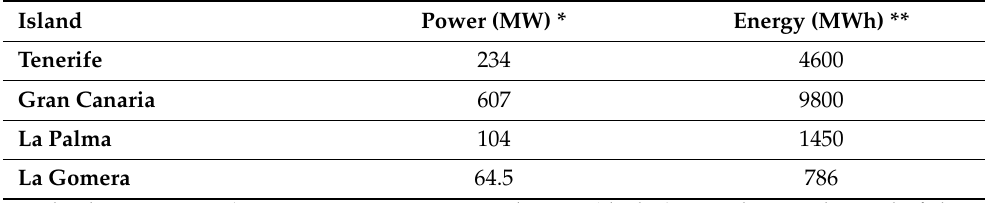
Table 5. Summary of the estimated reverse pumping storage capacity in the Canary Islands [43]. Island Power (MW) * Energy (MWh) ** Tenerife 234 4600 Gran Canaria 607 9800 La Palma 104 1450 La Gomera 64.5